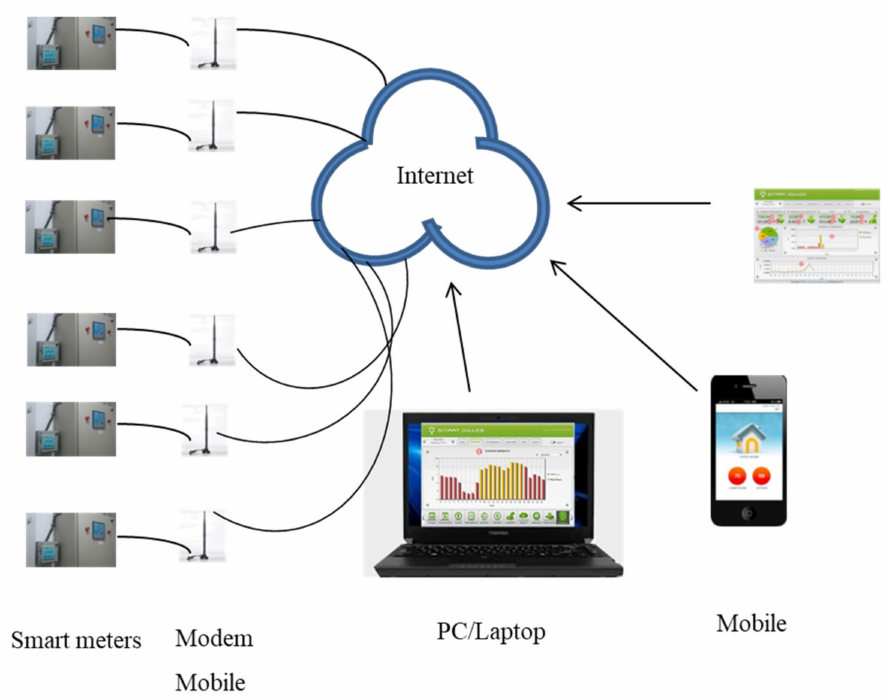
Figure 10. The proposed digital monitoring system using Smart Joules software.